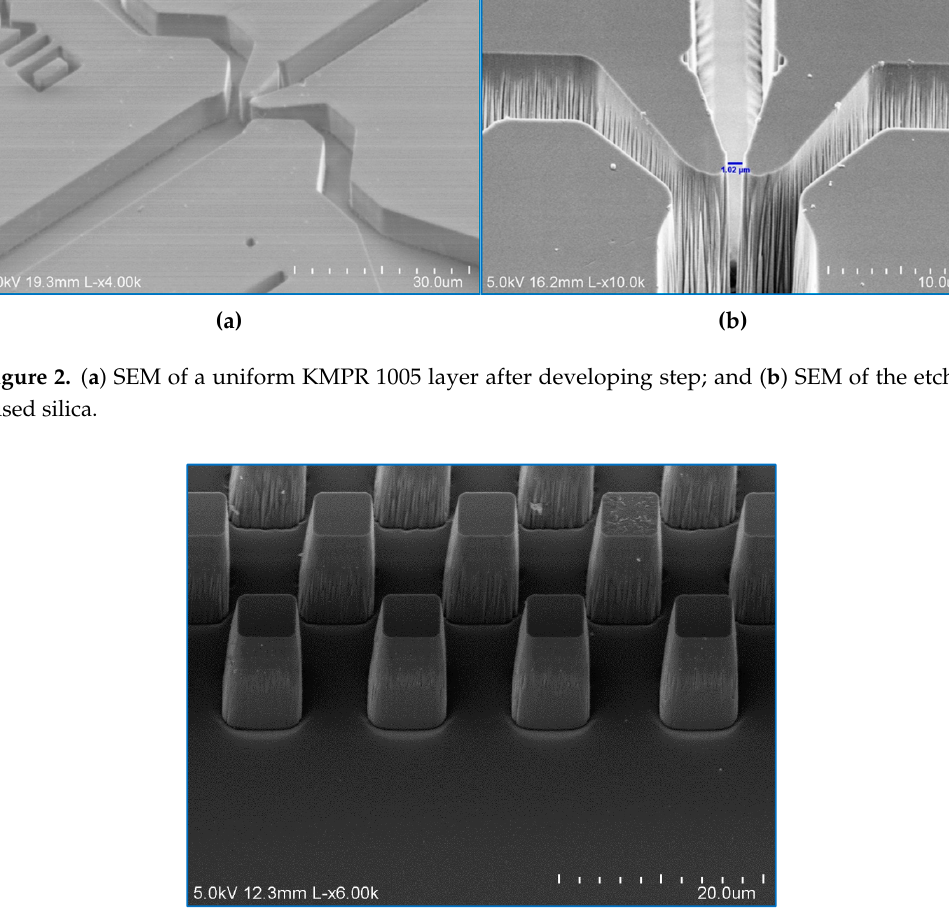
Figure 3. SEM of a filter region made of a series of fused silica micron-sized posts.